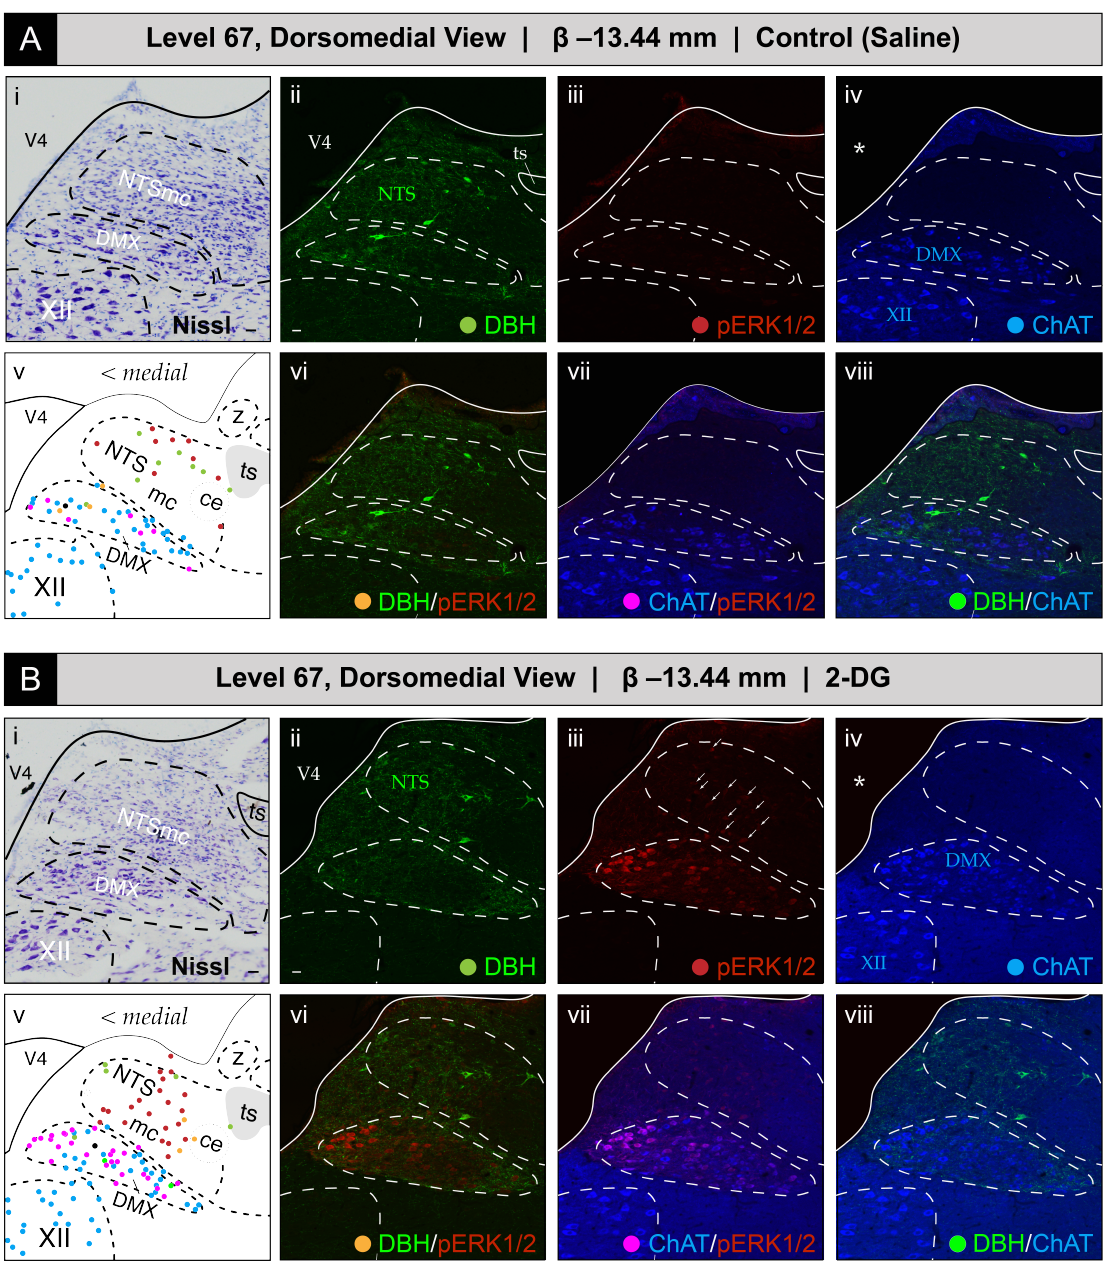
Figure 5. Glycemic challenge is associated with the recruitment of dorsal medulla (Winslow, 1733) [42] (MY) neurons mapped to atlas level 67 of Brain Maps 4.0 (BM4.0) [81]. Cytoarchitecture- and chemoarchitecture-based spatial analysis of distributed phosphorylated MAP kinase (pERK1/2) signal within dorsal RB neurons at the level of the nucleus of solitary tract (>1840) (NTS) ( BM4.0 level 67). ( A , B ) The panels display bright-field Nissl photomicrographs ( i ), single- ( ii – iv ) and dual-channel ( vi – viii ) fluorescence images, and BM4.0 atlas maps ( v ) for saline- (( A ); Subject K10-011) and 2-DG-treated (( B ); Subject K10-026) subjects of individual immunoreactivity patterns for dopamine β -hydroxylase (DBH, green ), phospho-ERK1/2 (pERK1/2, red ), and choline acetyltransferase (ChAT, blue ). The patterns fall near and within the boundaries for the NTS, dorsal motor nucleus of vagus nerve (>1840) (DMX) and hypoglossal nucleus (>1840) (XII). Note that the NTS label is colored green to signify its boundary determination using the pattern of immunoreactivity observed for DBH in the green channel, and